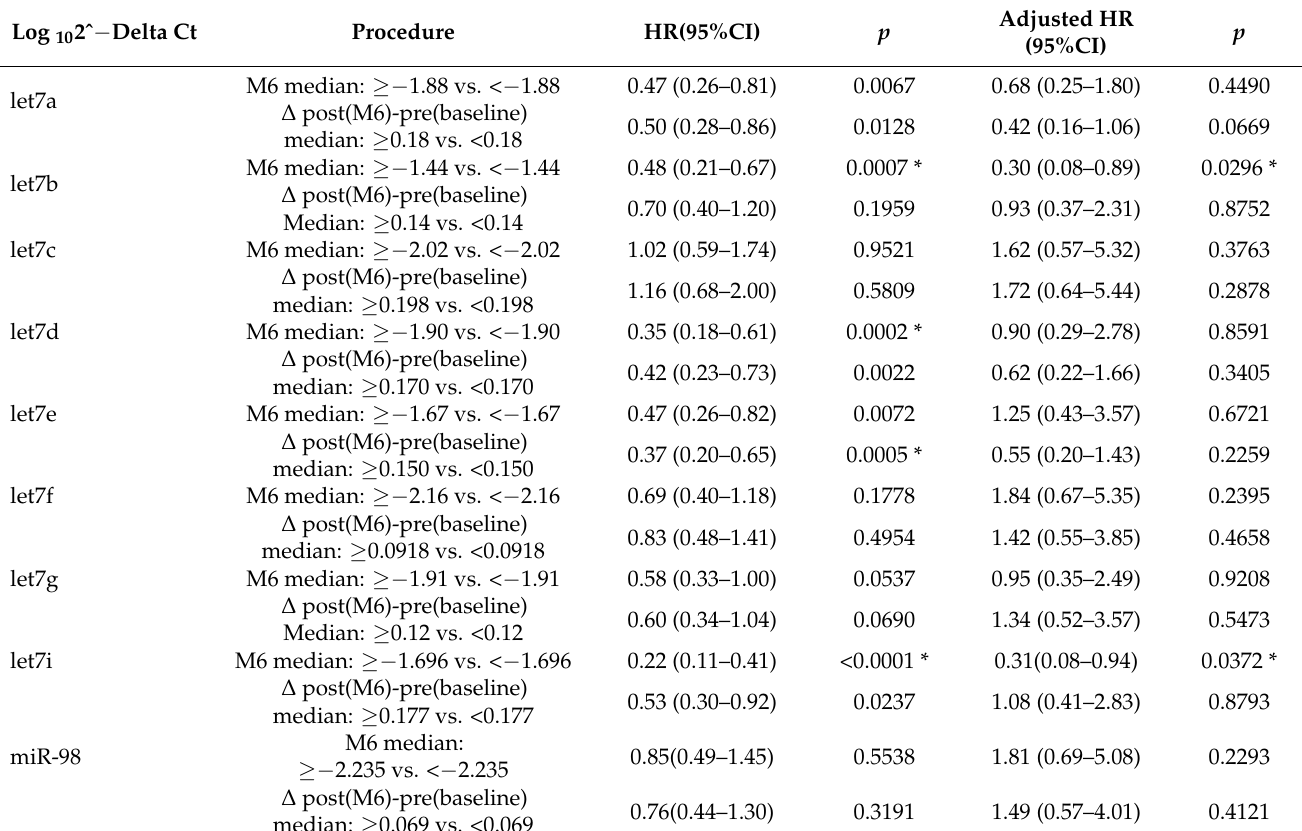
Table 4. Let-7 family associated with the development of HCC in the CHC patients after antiviral treatment (M6): Univariate and Multivariate Cox proportional hazard